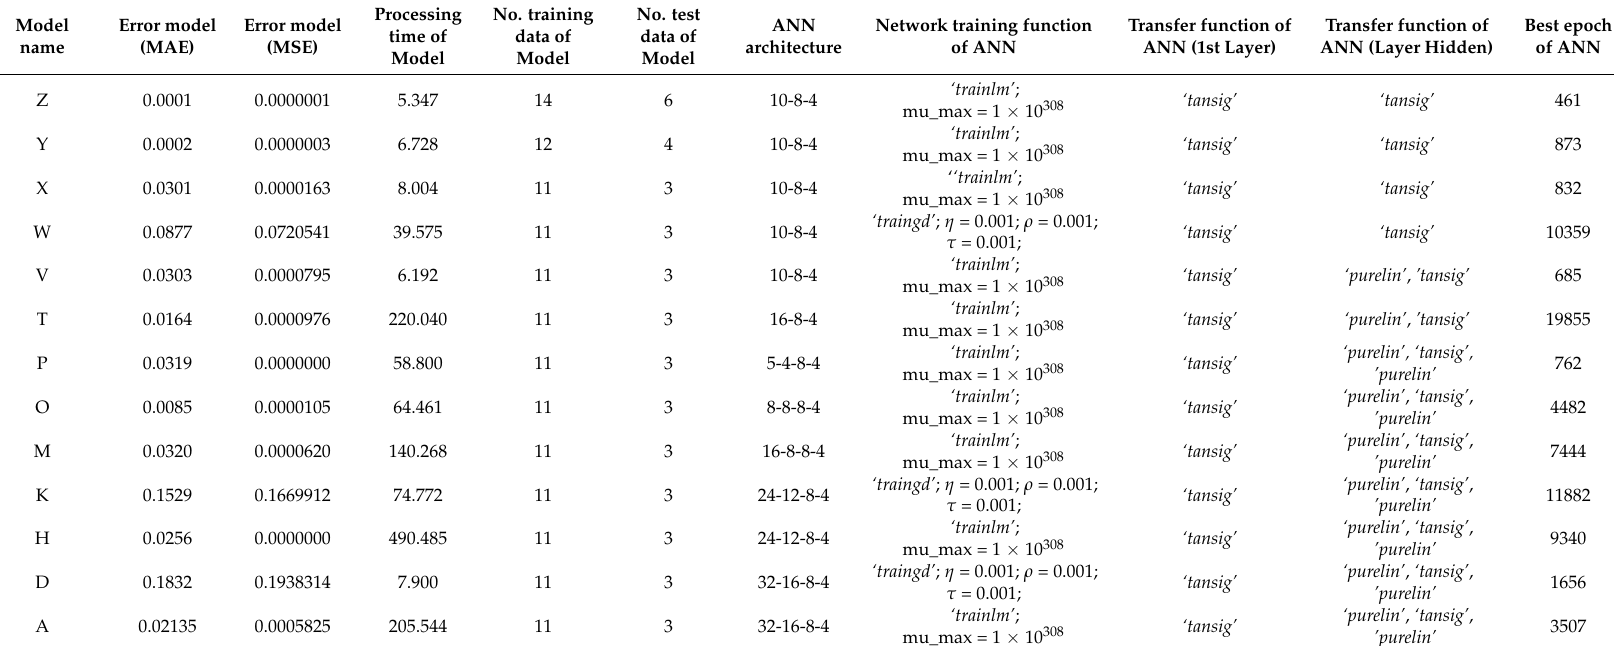
Table 4. Summary of the main characteristics and performance values of multi-criteria ANN models developed and